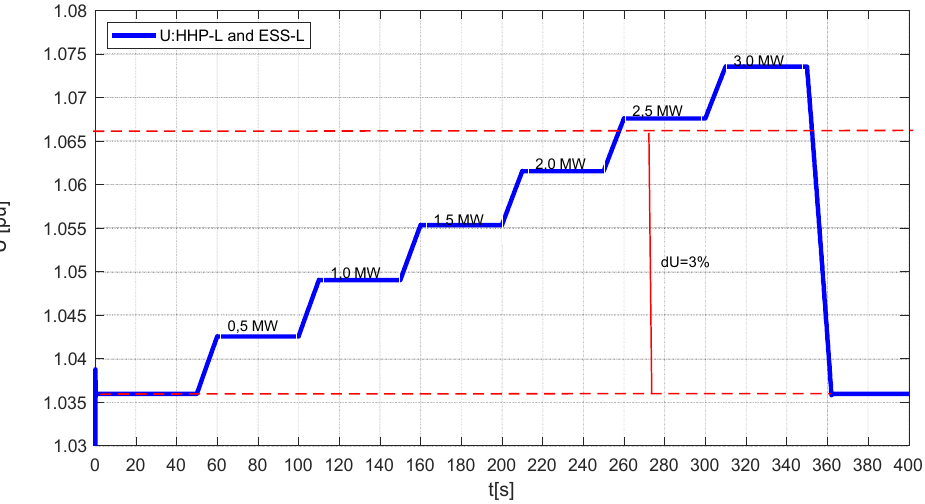
Figure 12. Voltage changes at the point of connection of MV HPP-L and ESS-L during the gradual increase of maximum power of power generators.